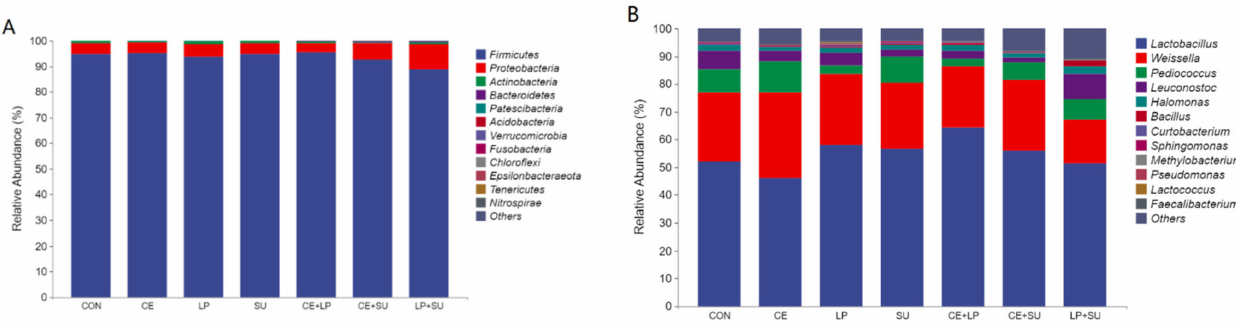
Figure 2. Accumulation map of bacterial communities at the phylum ( A ) and genus ( B ) levels for hybrid Pennisetum silage (CON, control group; CE, 100 U/g FM cellulase addition; LP, 1 × 10 6 cfu/g FM Lactobacillus plantarum addition; SU, 1% FM sucrose